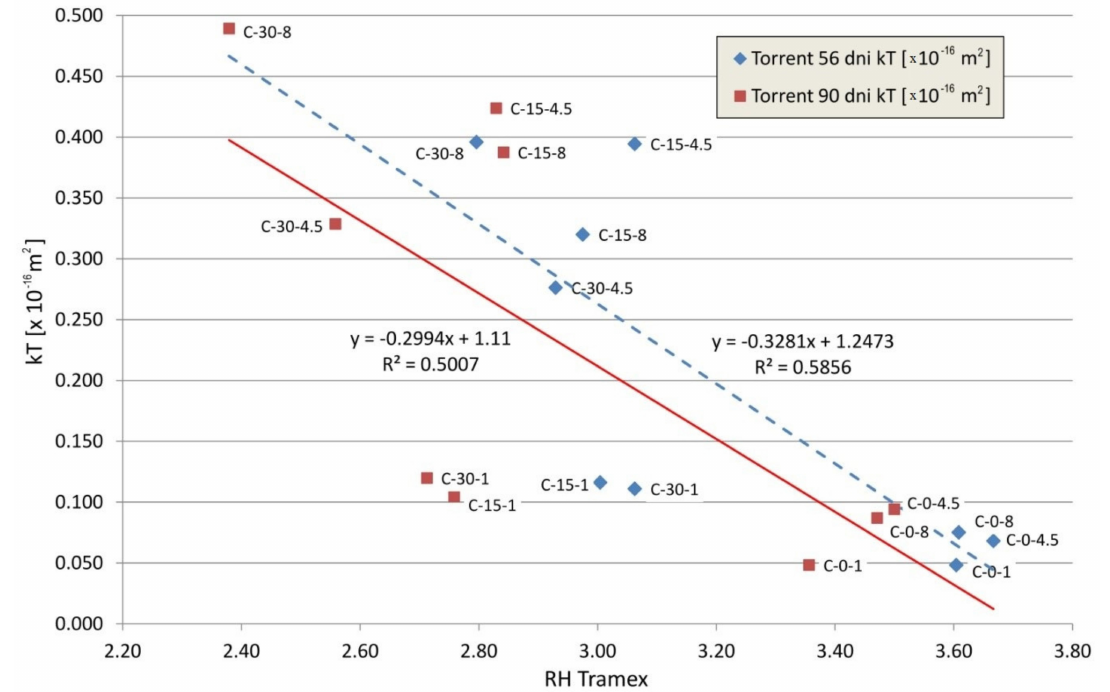
Figure 1. Air permeability after 56 and 90 days depending on the RH of the tested